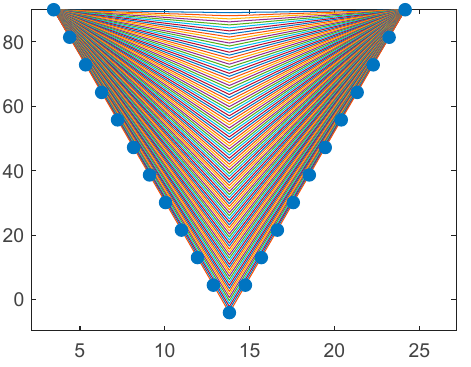
Figure 26. All iterated pre-defined paths and the final pre-defined path in case 2.